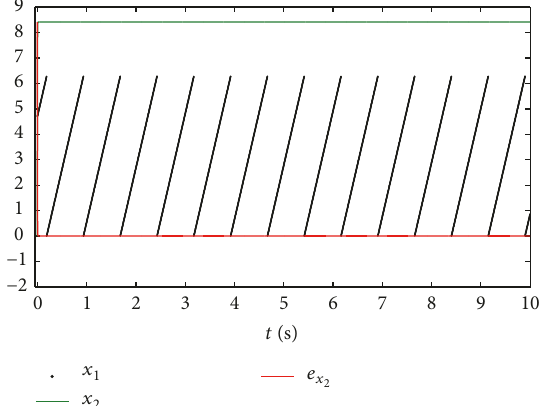
Figure 5: Double-cylinder with SDRE control by position and constant velocity ( 𝑥 2∗ = 16.83 rad/s = 20 km/h).